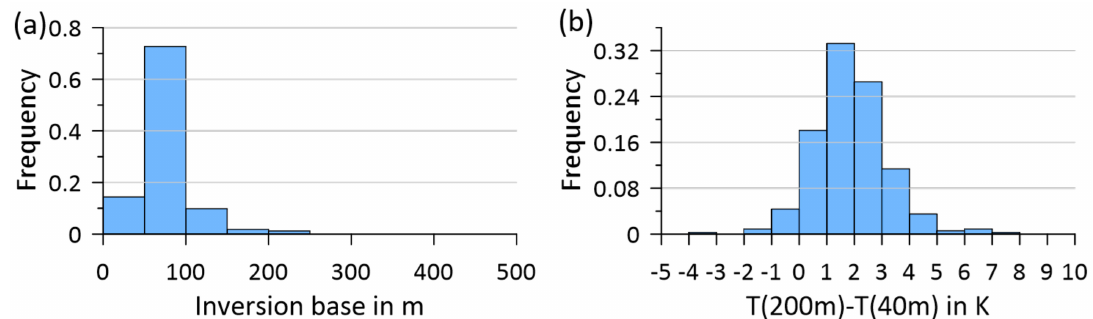
Figure 17. Statistics (relative frequencies) for ( a ) the height of the inversion base and ( b ) the temperature difference between 200 m and 40 m for all